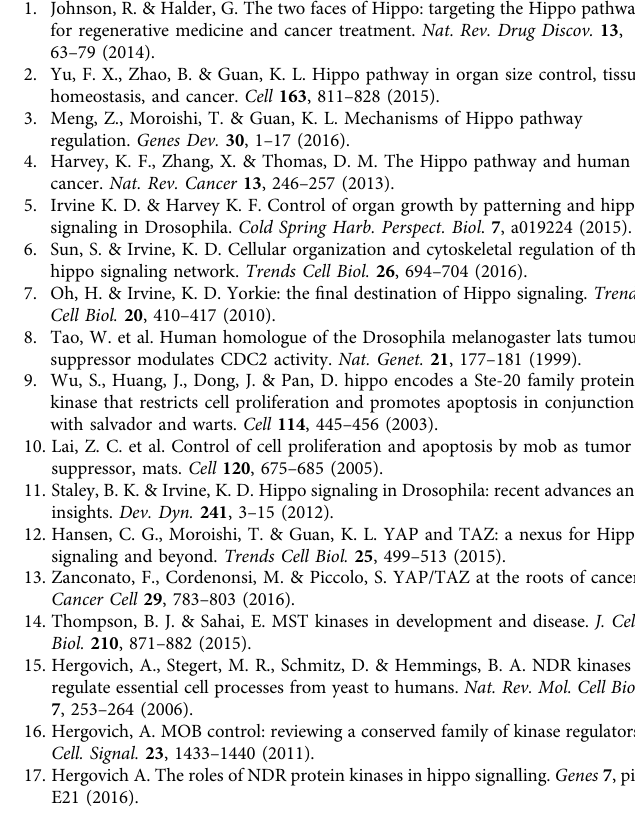
a-e. yw hsFLP/ + ;; FRT82B GFP/FRT82B mats roo f-j. yw hsFLP/ + ;; FRT82B GFP/FRT82B mats roo , ubi > MOB1-wt k-o. yw hsFLP/ + ;; FRT82B GFP/FRT82B mats roo , ubi > MOB1-DV p-t. yw hsFLP/ + ;; FRT82B GFP/FRT82B mats roo , ubi > MOB1-KEKE u-y. yw hsFLP/ + ;; FRT82B GFP/FRT82B mats roo , ubi >